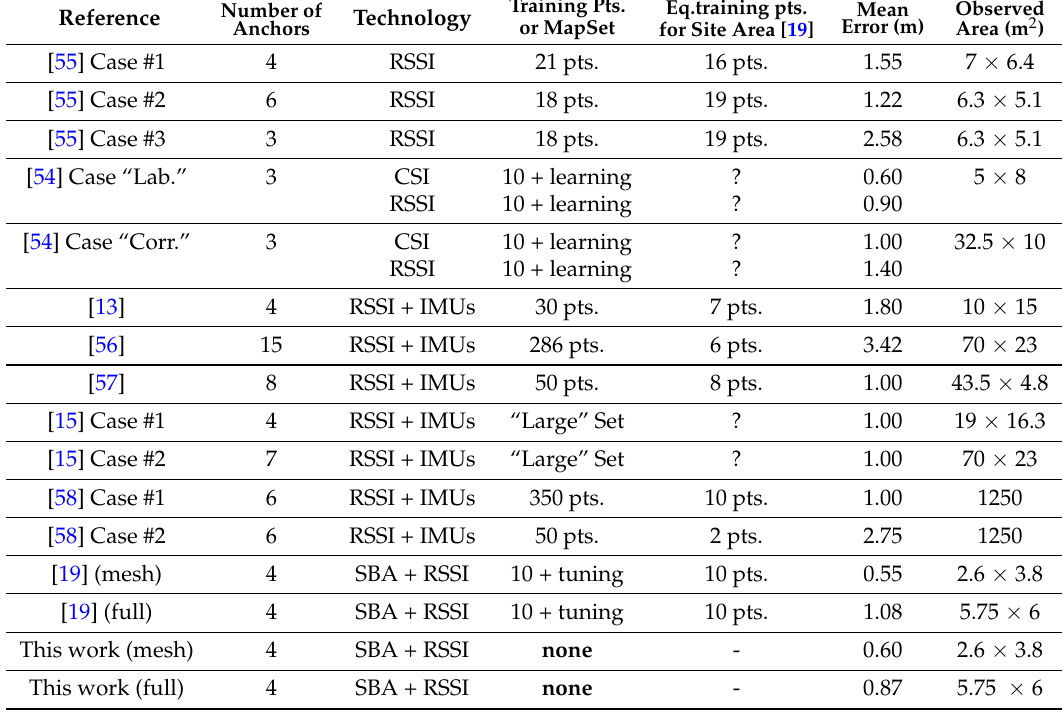
Table 9. Actual State-of-Art Localization System Comparison (inertial measurement units =